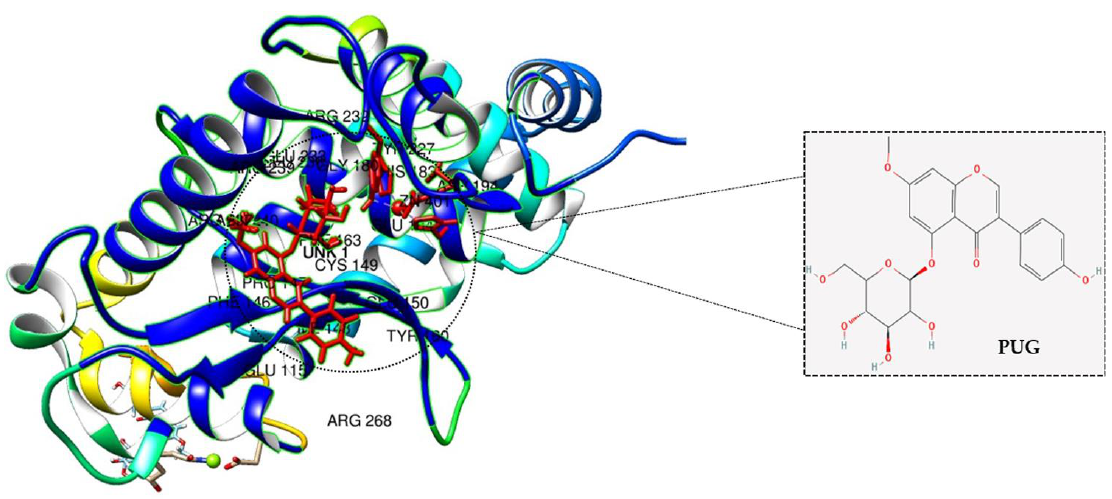
Figure 9. Molecular docking analysis of PUG with NF- κB: The ligand PUG (red) competently binds to the NF- κ B protein complex with its interrelated amino acids CYS, PHE, PRO, ARG, TYR, GLU, and GLY.